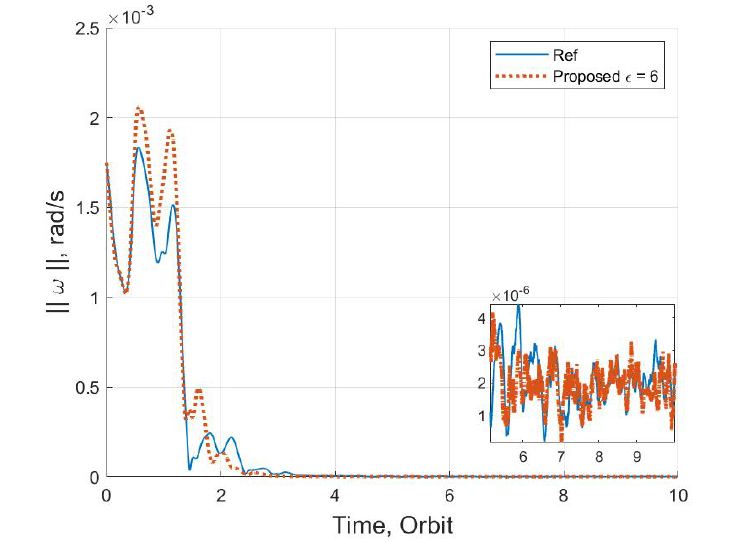
Figure 7. Spacecraft angular velocity magnitude